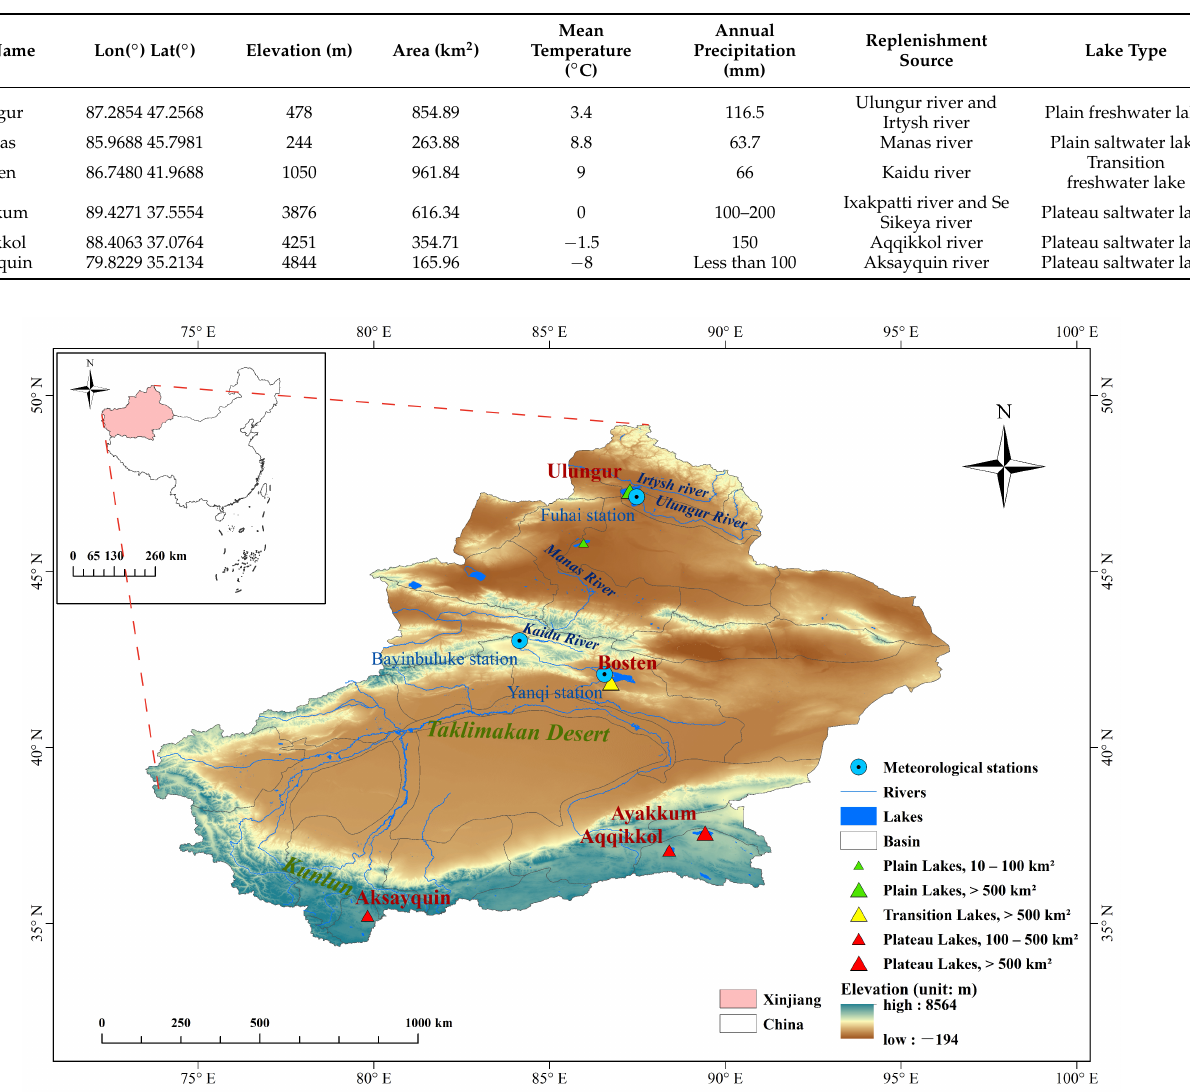
Table 1. List of six typical lakes and their main characteristics.